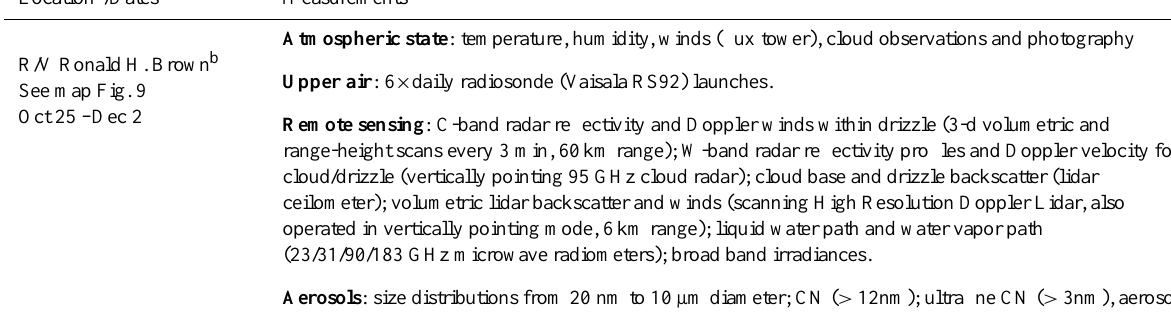
Table 3. Details of the Ronald H. Brown (RHB) measurements in VOCALS-REx. Location a /Dates Measurements